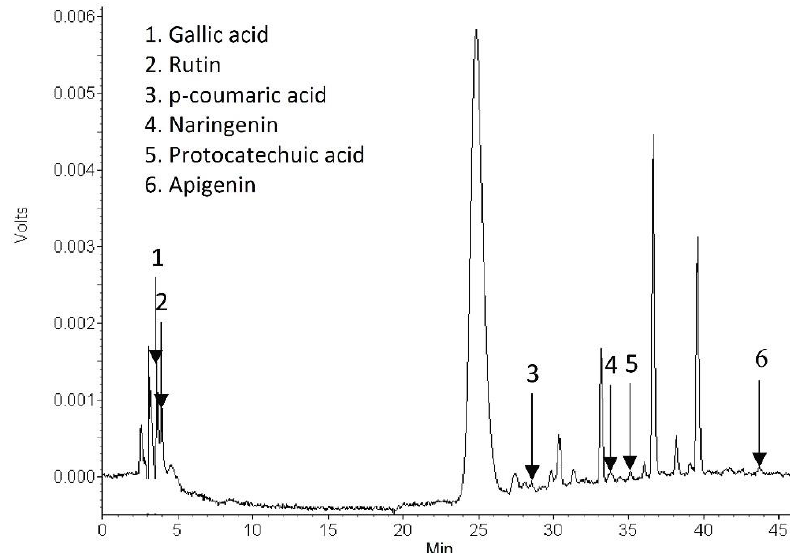
Figure 1. HPLC chromatogram of methanol extract from the carrot peel prepared by microwave drying at 1200 W, with UV-VIS detector set at 340 nm.